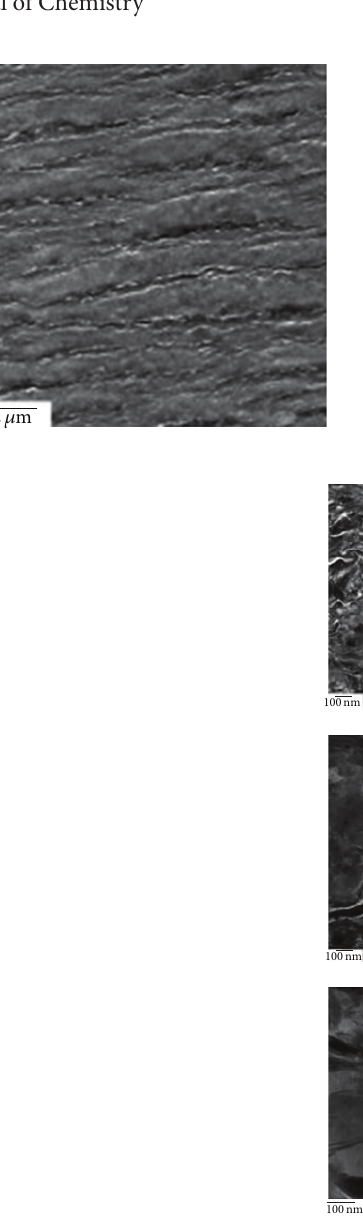
at 2𝜃 = 6.06 ∘ , 16.65 ∘ , and 22.28 ∘ . Na-MMT exhibits typical reflection at 2𝜃 = 9.6 ∘ corresponding to 𝑑 001 is 9.6 ˚A.